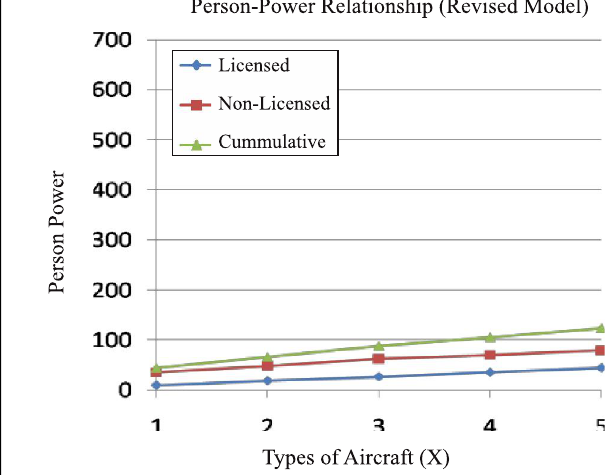
FIG. 5. PERSON-POWER RELATIONSHIP VS AIRCRAFT TYPES IN REVISED